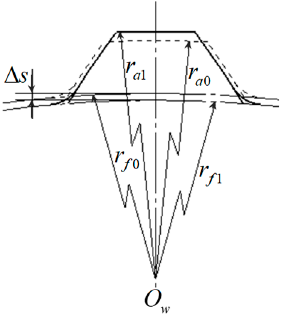
Figure 3. Sketch of compression amount (taking splined profile as an example) [11].